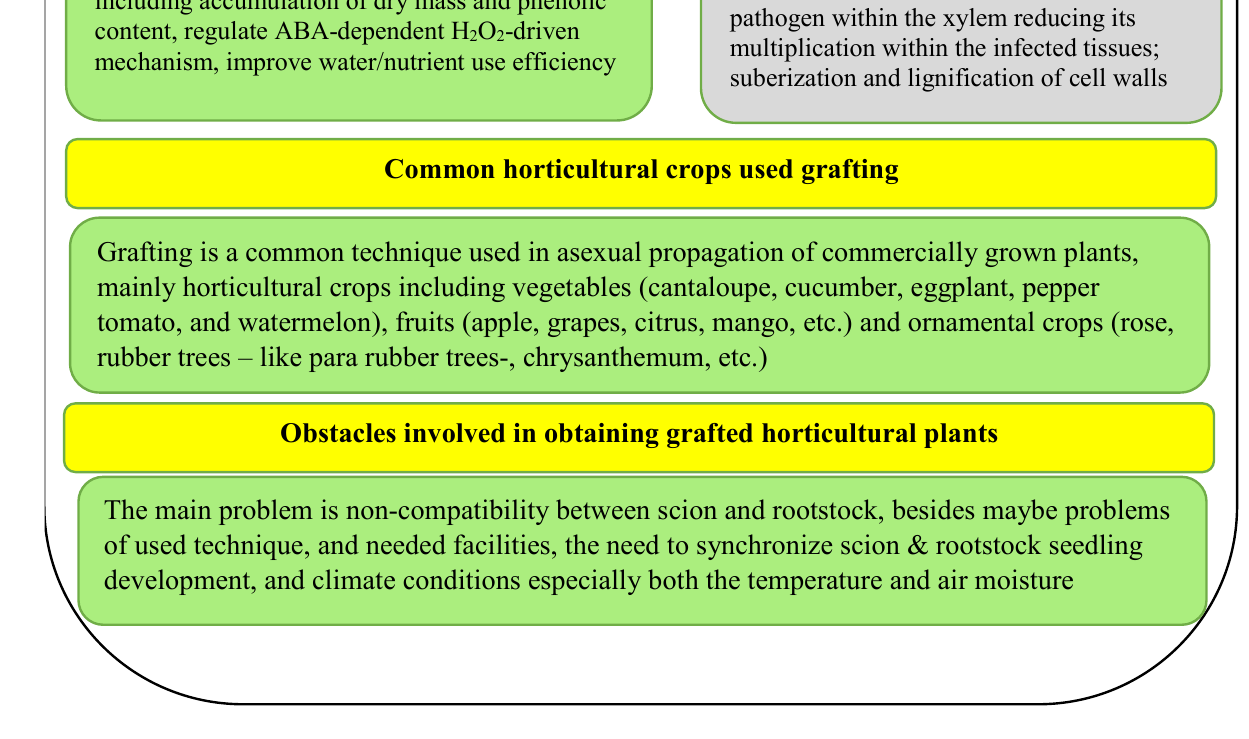
Figure 5. General overview for the grafting process, including the mechanism under biotic and abiotic stress, different plant species using grafting, and the challenges that face this technique. Sources: [28,35–37,57,65].